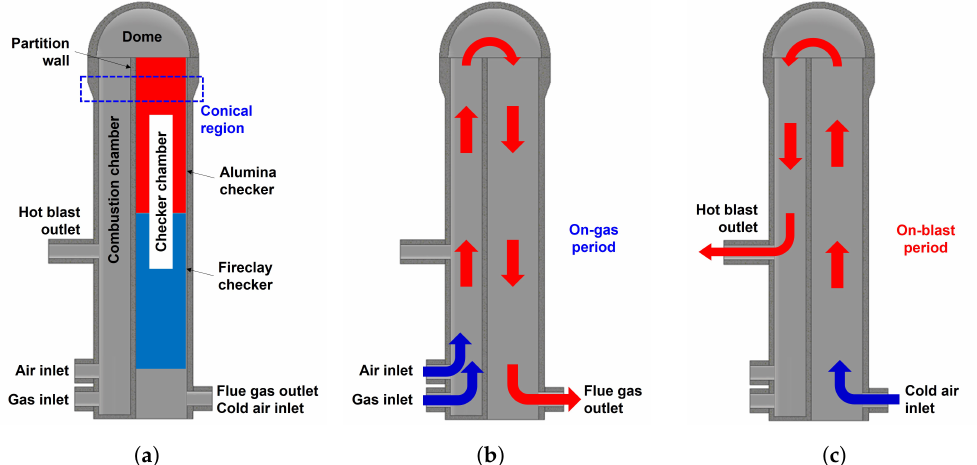
Figure 1. ( a ) Schematic of the internal combustion hot blast stove, ( b ) fluid flow in on-gas, and ( c ) on-blast